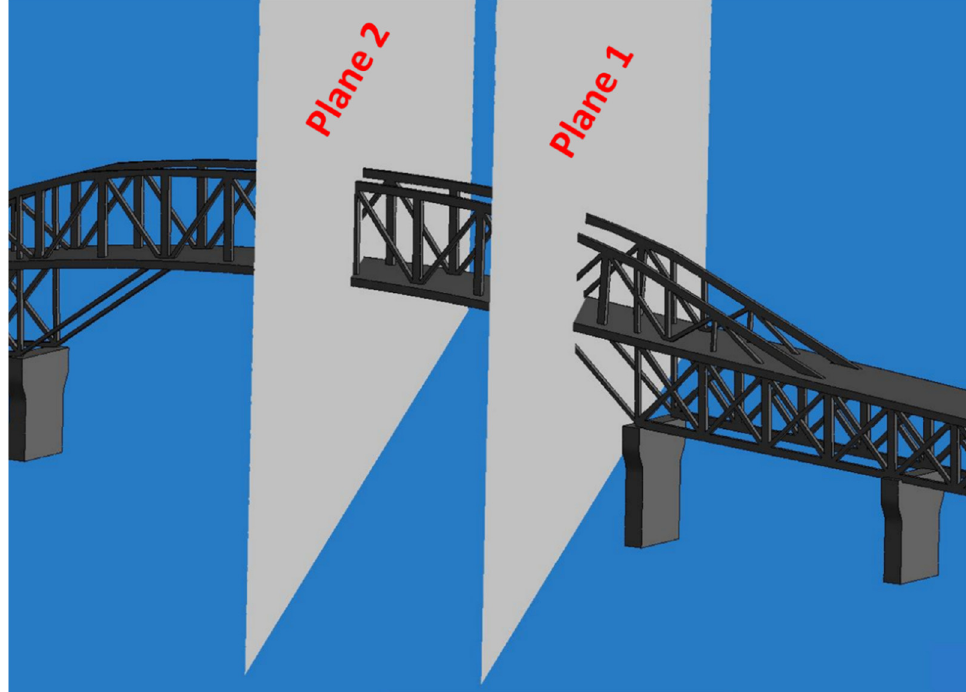
Figure 8. Two cross-sectional planes selected to present the wind speed results.